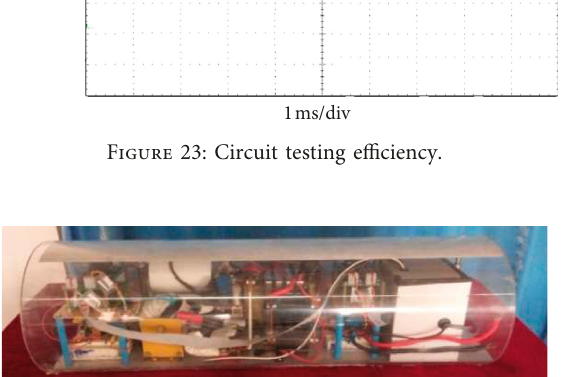
Figure 24: The physical picture of the marine transmitter.